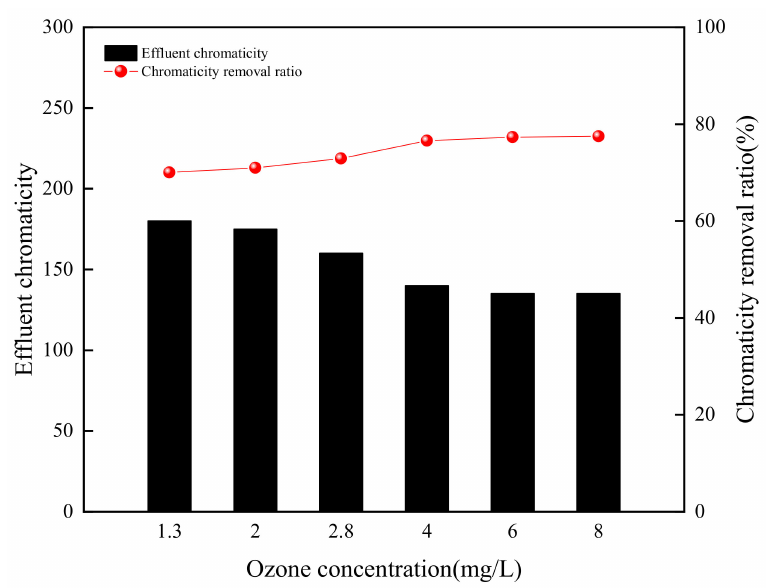
Figure 6. Effect of ozone concentration on chromaticity removal (pH value = 3).